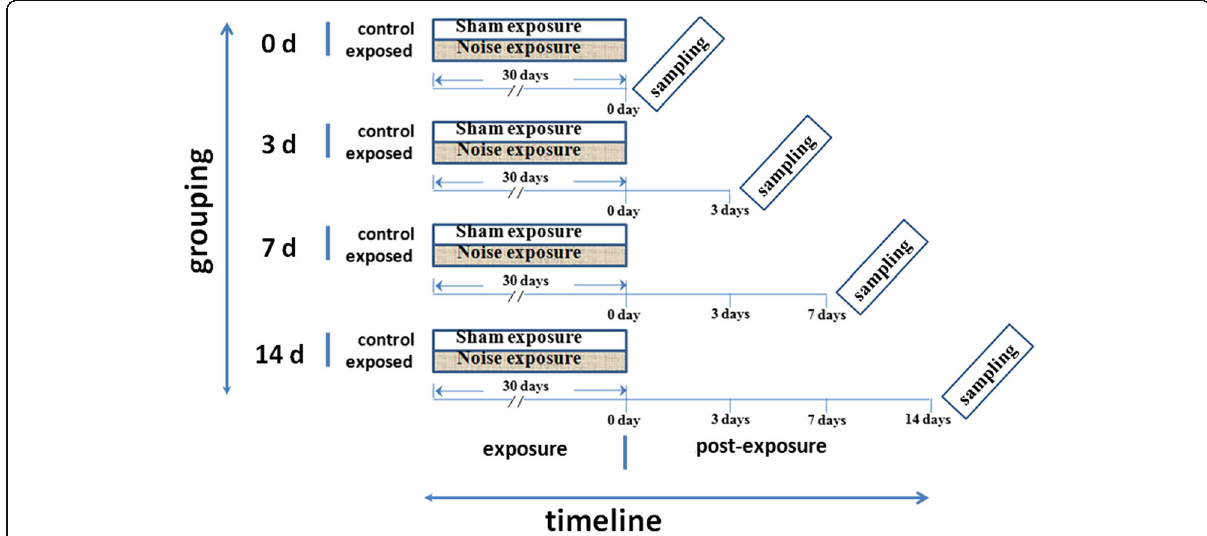
Fig. 1 Experimental timeline. The rats were randomly assigned to four groups according to when the end-point evaluation was performed (0, 3, 7, and 14 days following the final noise exposure). Each group was further subdivided into control and exposed subgroups, in which the animals were subjected to 30 successive days of noise exposure as indicated by the gray area within the 30-day period. Sham (no noise) exposure, as indicated by the blank segments in the 30-day period, was performed on the animals in the control group for 30